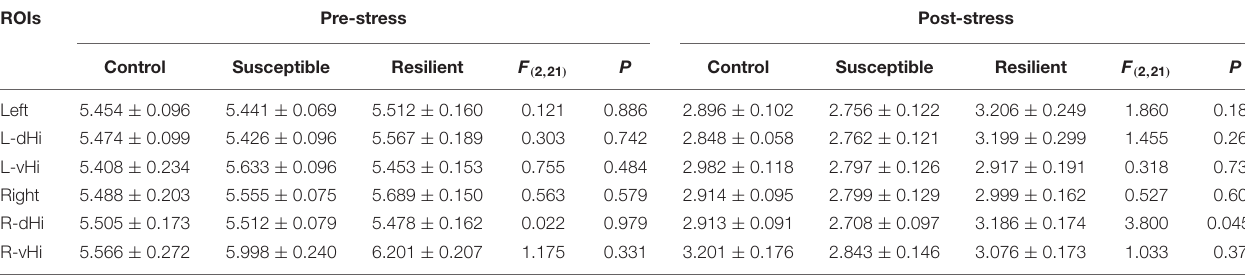
TABLE 3 | Group comparisons of pre- and post-stress hippocampal RD values (10 − 4 mm 2 /s). ROIs Pre-stress Post-stress Control Susceptible Resilient F ( 2 , 21 ) P Control Susceptible Resilient F ( 2 , 21 ) Left